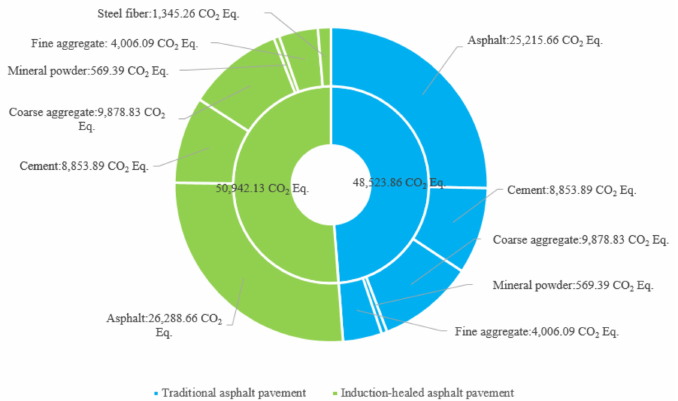
Figure 9. Greenhouse gas emissions of two asphalt pavements in the material manufacturing stage.